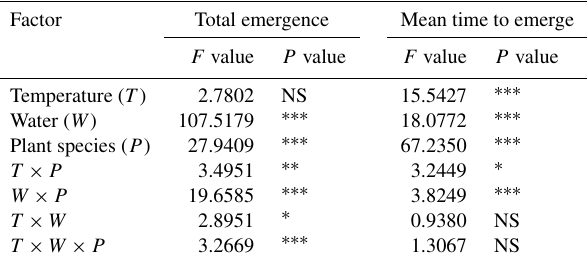
Table 3. Effects of climate factors (temperature and water) and plant species types, and interactive effects of these factors on total emergence and mean time to emerge. Statistical significance